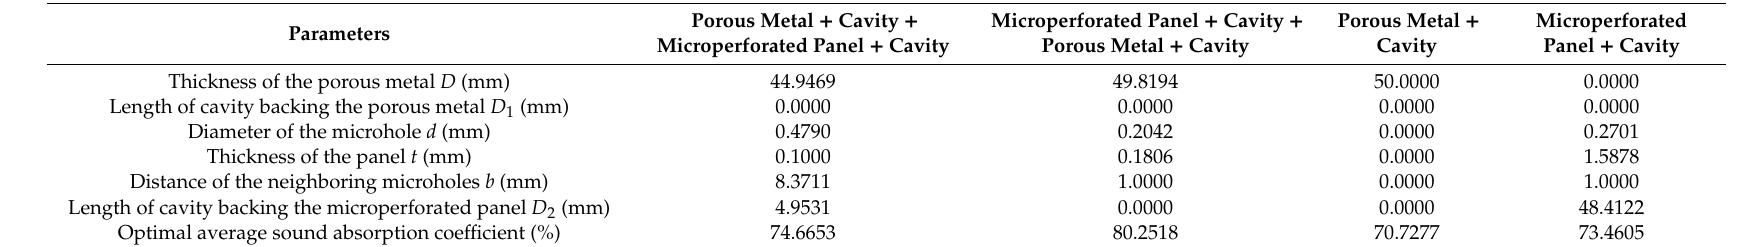
Table 2. The obtained optimal structural parameters when the limited total thickness was 50 mm.